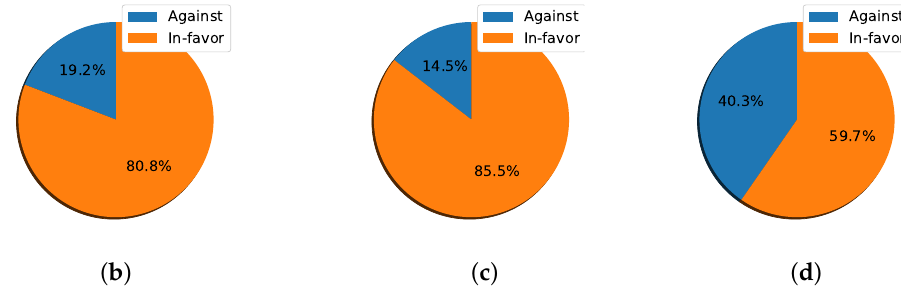
Figure 8. The percentage of the In-favor and Against tweets of the three events occurring in the second semester of the 2020 academic year. ( a ) A4. ( b ) A5. ( c ) A6. ( d )